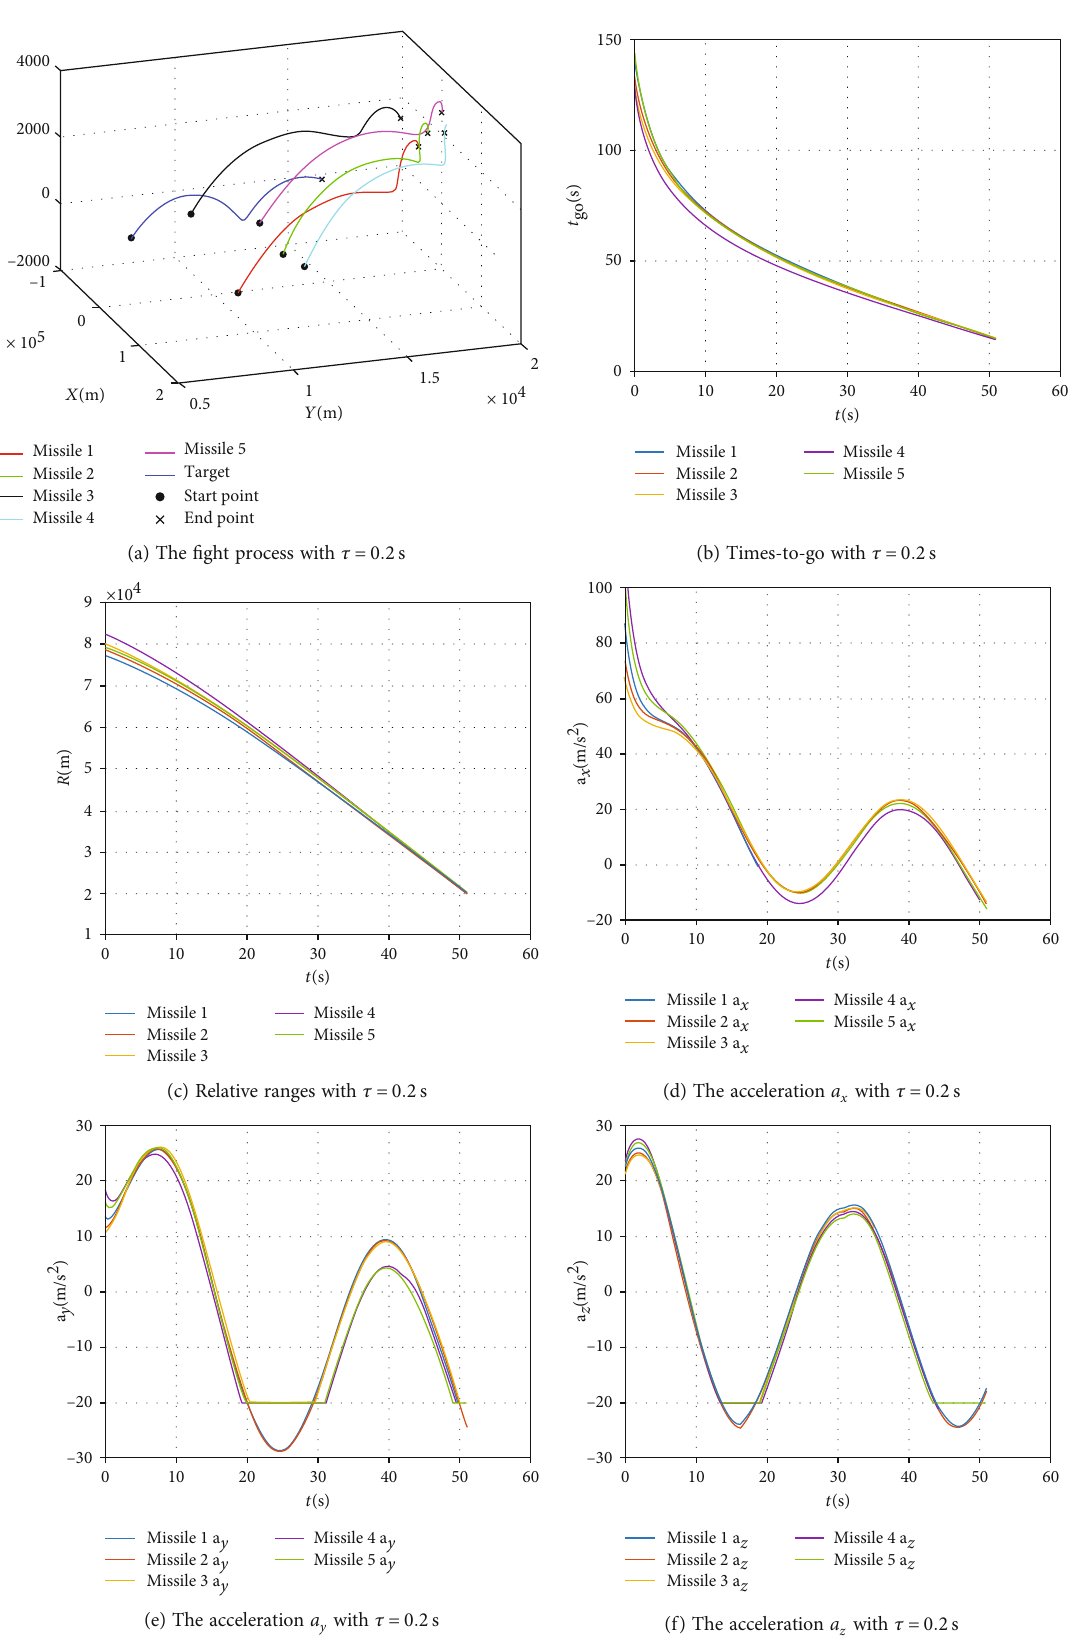
Figure 5: The simulation results with delay τ = 0 : 2s